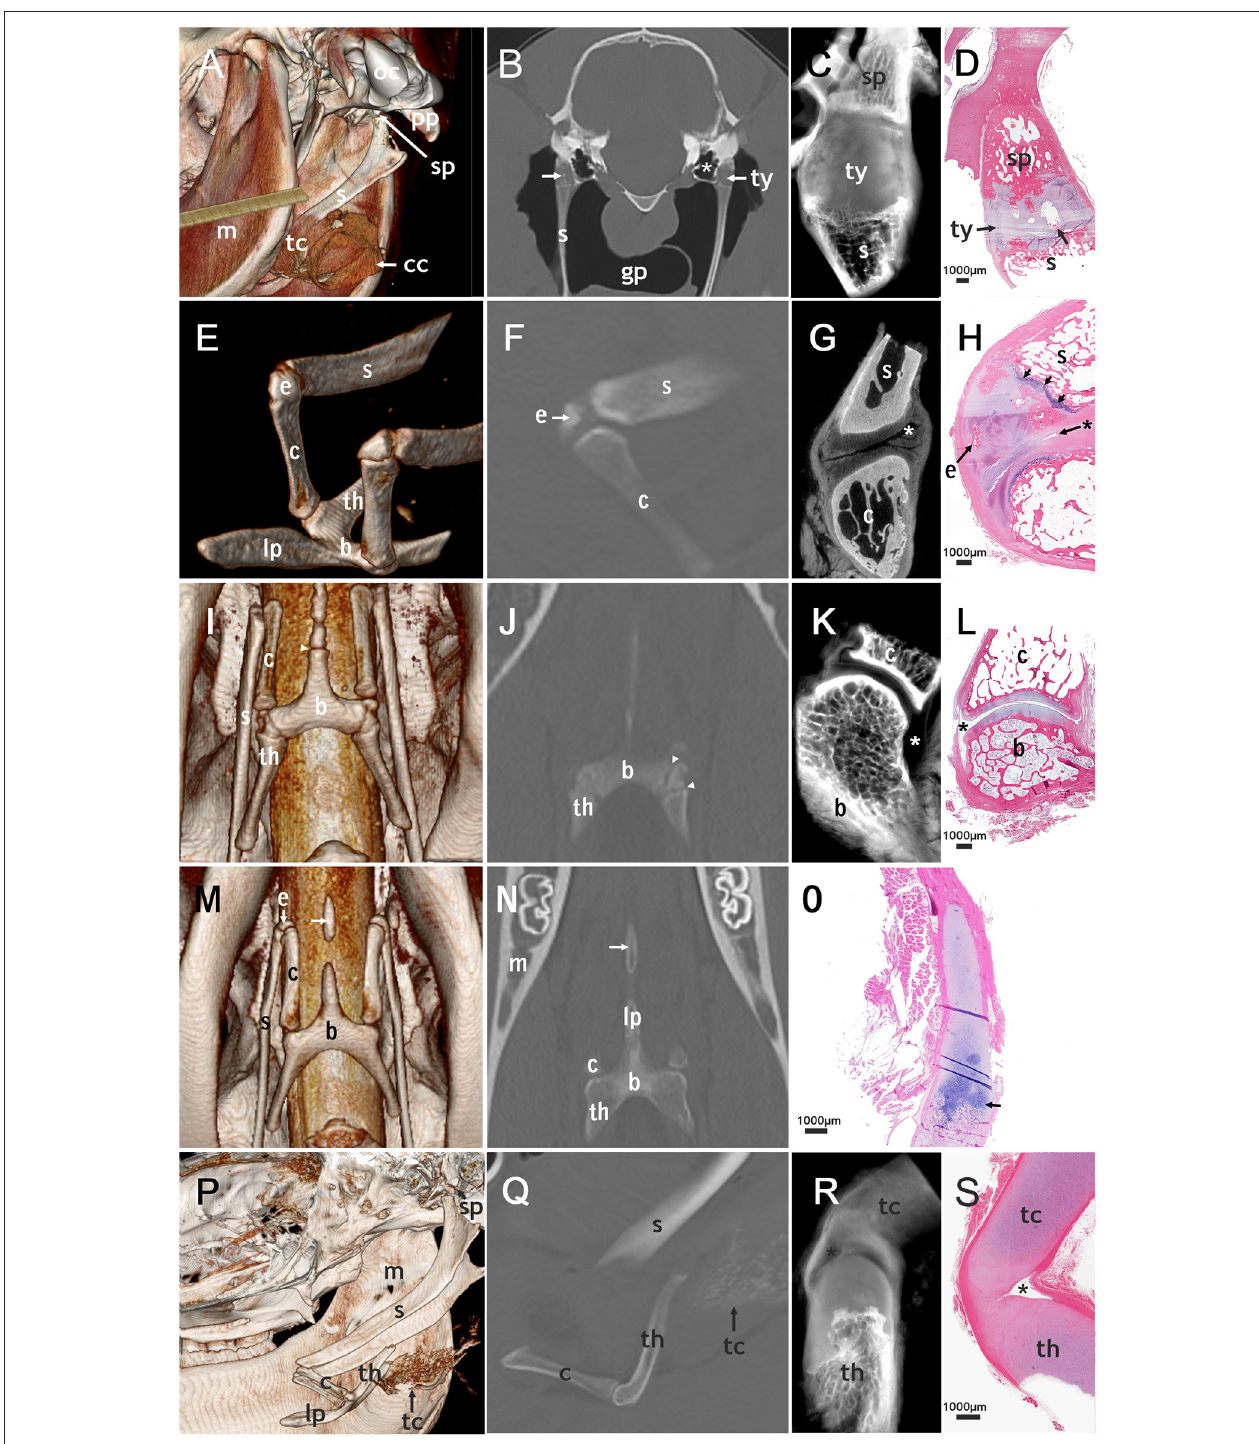
FIGURE 2 | Correlated imaging: first column: 3D image; second column: CT image; third column: micro-CT image; last column: histological section. First row: temporohyoid joint: (A) : image from caudoventral. (B–D) : transversal plane. (A) Occipital condyle (oc) and paracondylar process (pp) are indicated. The tympanohyoid (ty) that connects the stylohyoid process (sp) and the stylohyoid (s) could not be distinguished on this picture. The thyroid cartilage (tc) and cricoid cartilage (cc) surround the tracheal tube. (B) areas of mineralization of the tympanohyoid (arrow) in a 17.5-year-old horse. The guttural pouch (gp) surrounds the stylohyoids. (B,C) : The tympanic bulla (*) is located directly medial to the temporohyoid joint. (D) Mineralization (arrow) in the tympanohyoid cartilage of a 22.1-year-old horse.